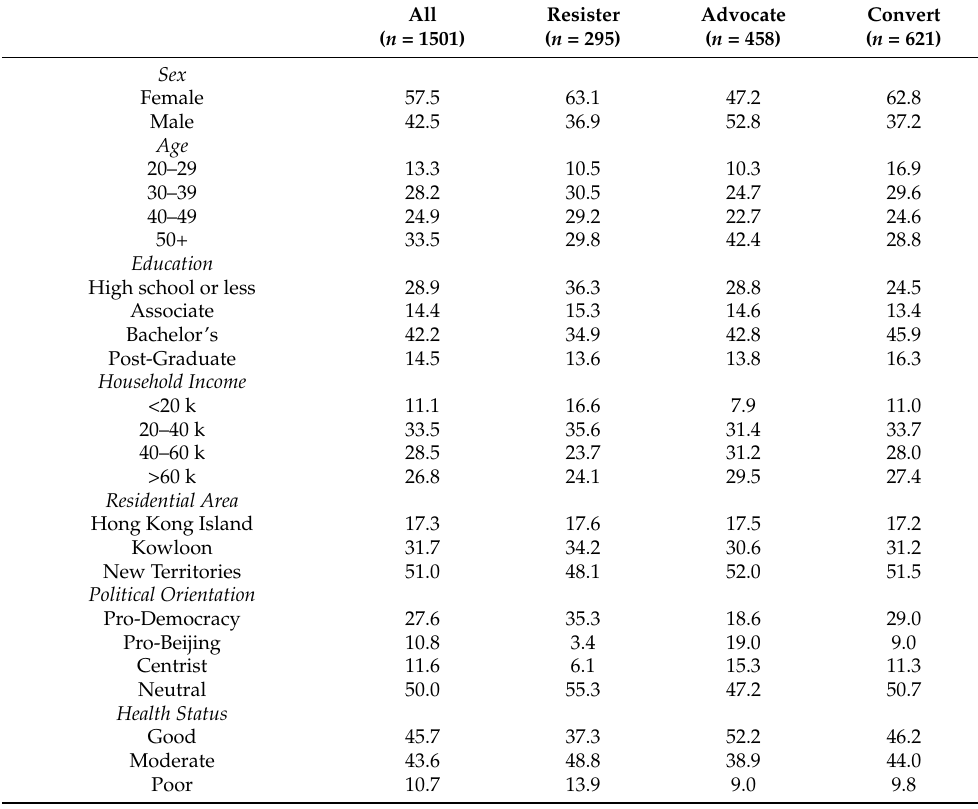
Table 1. Sociodemographic characteristics of the Hong Kong sample